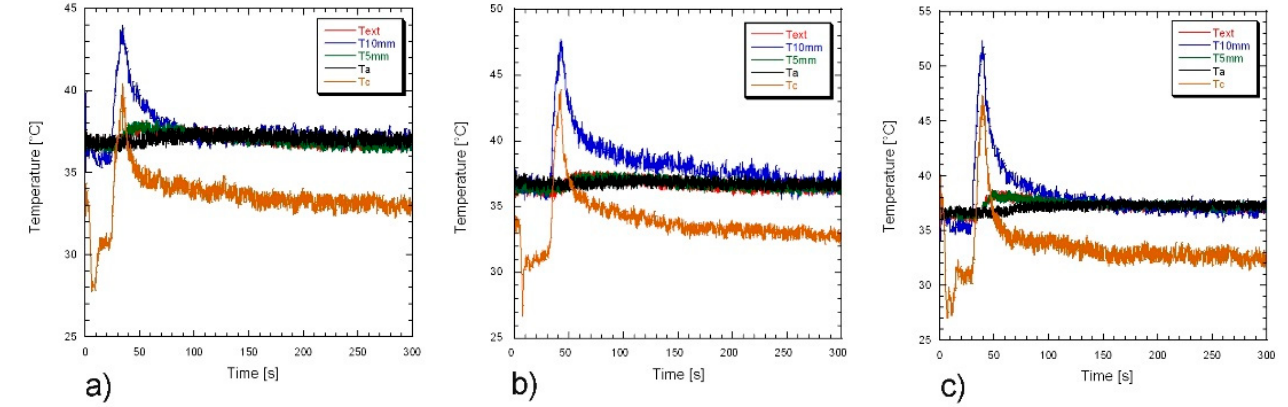
Figure 6. Temperature profiles in different regions of the tooth by heating sodium-hypochlorite through the ML-12 plugger using temperature set at 100 ◦ C ( a ), 150 ◦ C ( b ), and 180 ◦ C ( c ).